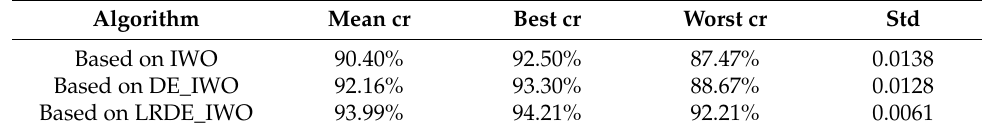
Table 3. Comparison of the results in the 50 m × 50 m area and 35 nodes.